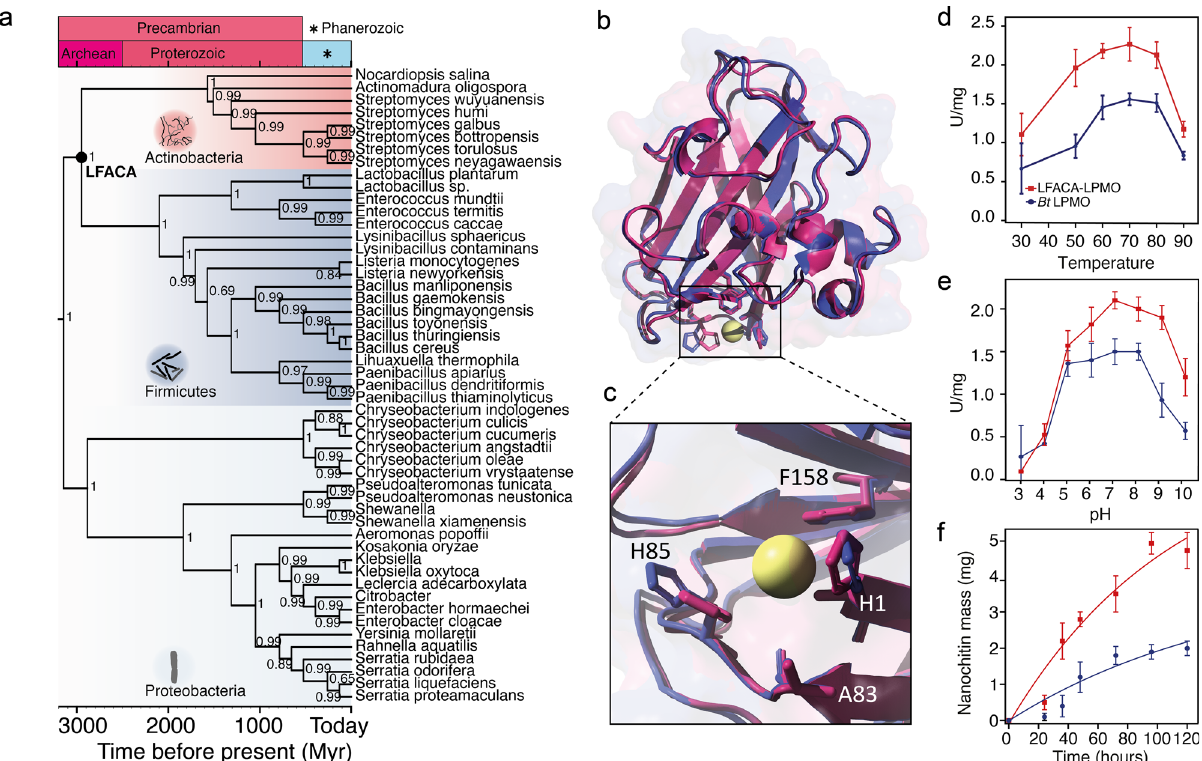
Fig. 2 Ancestral LPMO reconstruction and characterization. a Uncorrelated lognormal relaxed-clock chronogram of LPMO with geological time inferred with Bayesian inference. A total of fi fty-one LPMO homologous sequences were used. Geological scale and times are indicated in the upper bar. The selected internal node for experimental validation is shown with a circle LFACA (Last Firmicutes Actinobacteria Common Ancestor). b LFACA-LPMO (red) and Bt LPMO (blue) AlphaFold2 prediction structure alignment with RMSD value of 0.428. c Active site Cu ion (yellow) and neighboring interacting residues at approximately 5 Å distance, conforming the so-called “ histidine-brace ” . d 2,6-DMP activity assay for LFACA-LPMO (red squares) and Bt LPMO (blue dots) at different temperatures, 30 °C to 90 °C. e pH activity assay from pH 3 to pH 10, LFACA-LPMO (red squares) and Bt LPMO (blue dots). For each data point, six independent experiments were collected. Data are shown as average ± S.E.M. f Generation of nanochitin over time by oxidative cleavage of α -Chitin by LFACA-LPMO (red squares) and extant Bt LPMO (blue dots). For each data point, three independent experiments were collected. Data are shown as average ±